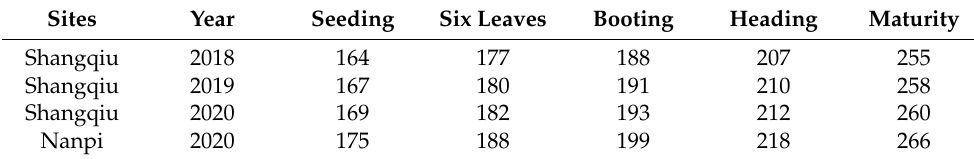
Table 1. Observed maize phenology in day-of-year (DOY) format at the sites in Nanpi and